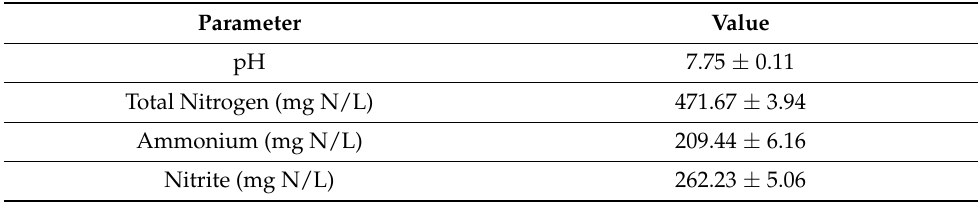
Table 1. Characteristics of synthetic wastewater in this study.